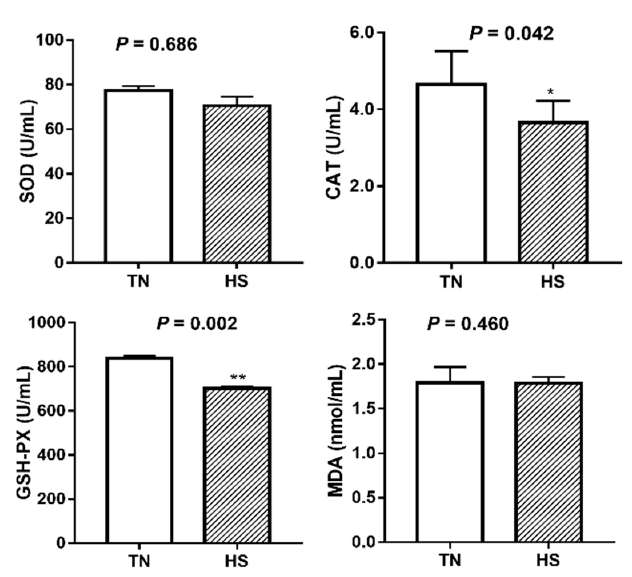
Figure 1. The effects of three weeks of thermal neutral (TN) or heat stress (HS) conditions on activities of SOD, CAT, GSH-PX, and MDA level in the serum of finishing pigs. Data are mean ± SD; n = 8 for each group. * p < 0.05 and ** p < 0.01 before vs. after heat stress.